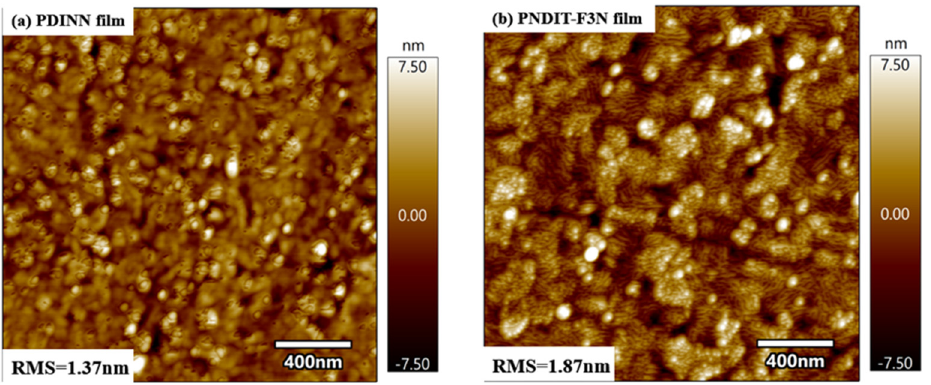
Figure 7. AFM images of PDINN and PNDIT − F3N.